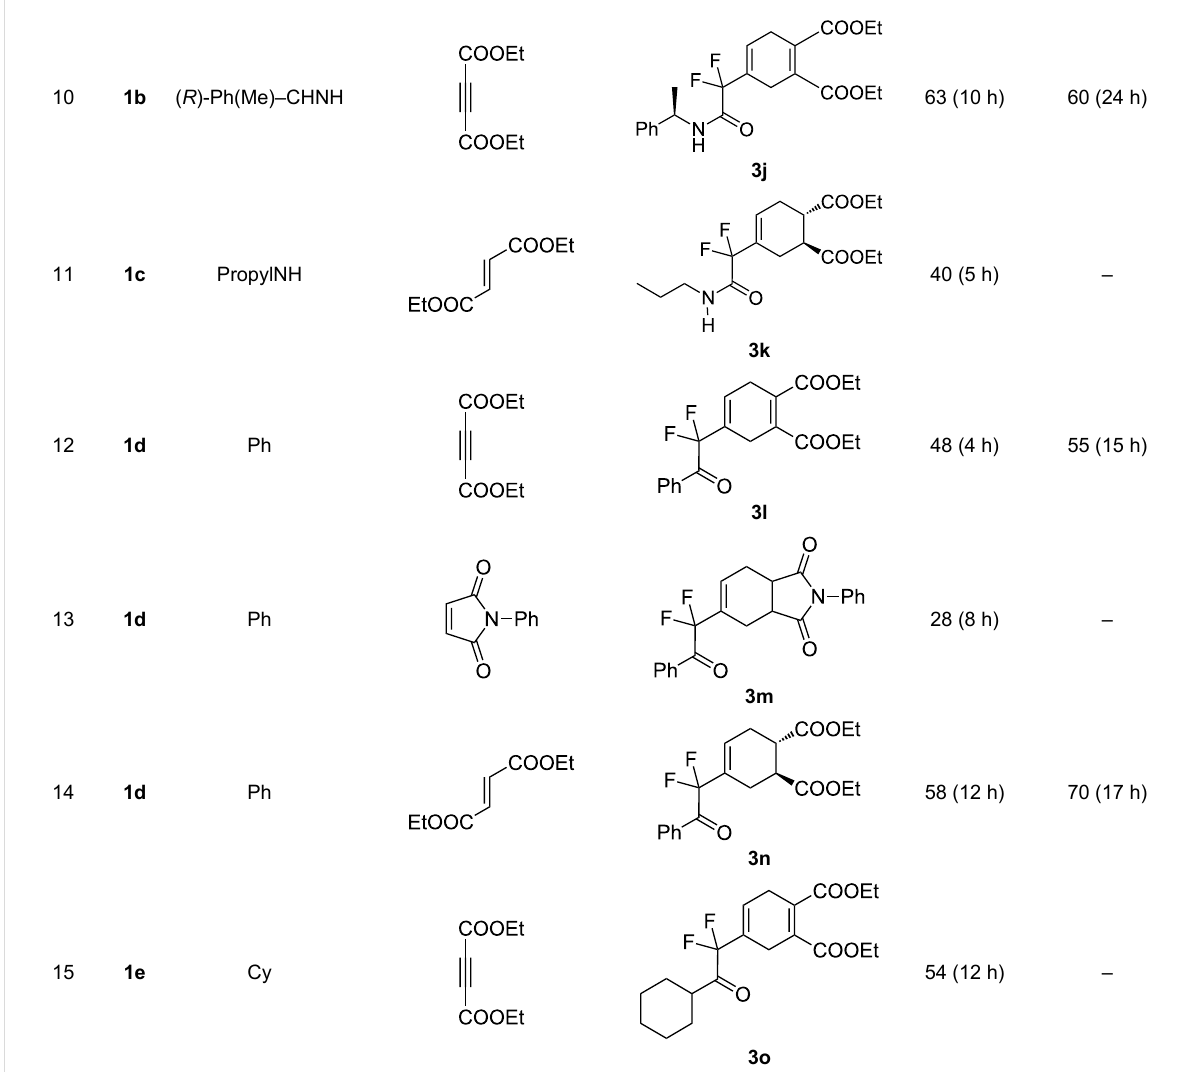
Table 1: Preparation of compounds 3 by one-pot CEYM–Diels–Alder reaction of substrates 1 (method A).